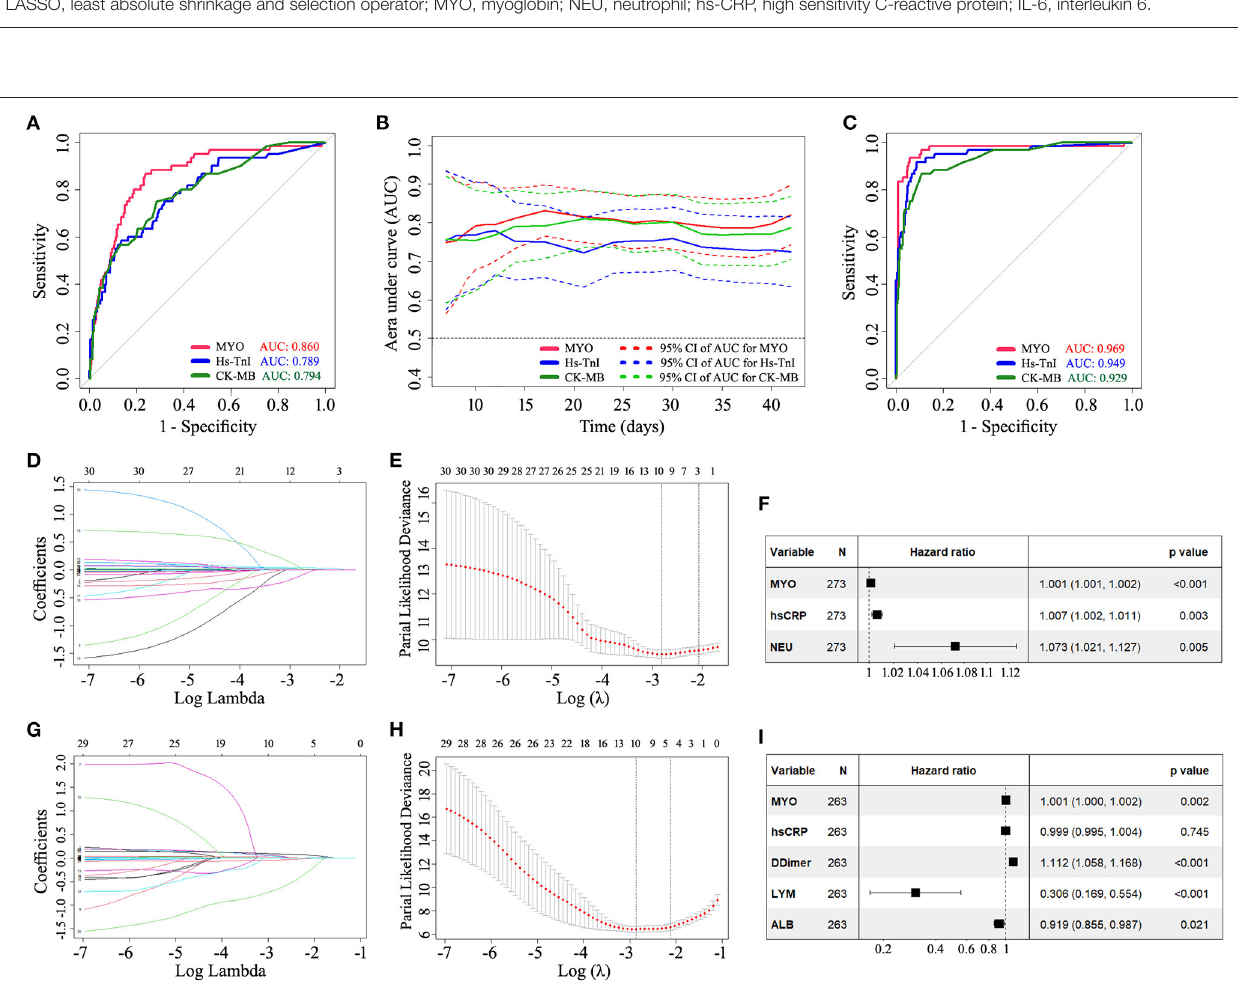
FIGURE 4 | laboratory parameters. Dotted vertical lines were drawn at the optimal values by using the minimum criteria and the 1 SE of the minimum criteria (the 1-SE criteria). Five variables with non-zero coefficients (MYO, NEU, hs-CRP, IL-6, and D-dimer) were identified. (B) In multivariate analysis, all five variables had p -values < 0.05. (C) LASSO coefficient profiles of the 30 variables including age, sex, comorbidities, physical examinations, and late-stage results of laboratory parameters. Three variables (MYO, hs-CRP, and D-dimer) with non-zero coefficients were identified. (D) In multivariate analysis, they all had p -values less than 0.05. LASSO, least absolute shrinkage and selection operator; MYO, myoglobin; NEU, neutrophil; hs-CRP, high sensitivity C-reactive protein; IL-6, interleukin 6.